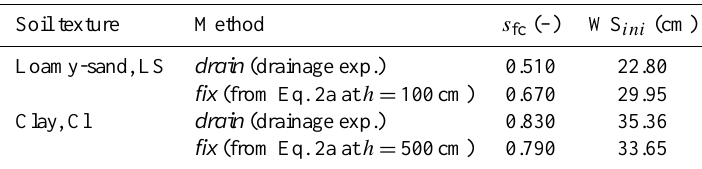
Table 4. Relative soil moisture at field capacity, s fc , for BM and soil-water storage capacity, WS ini , in the system at the start of the simulation run.